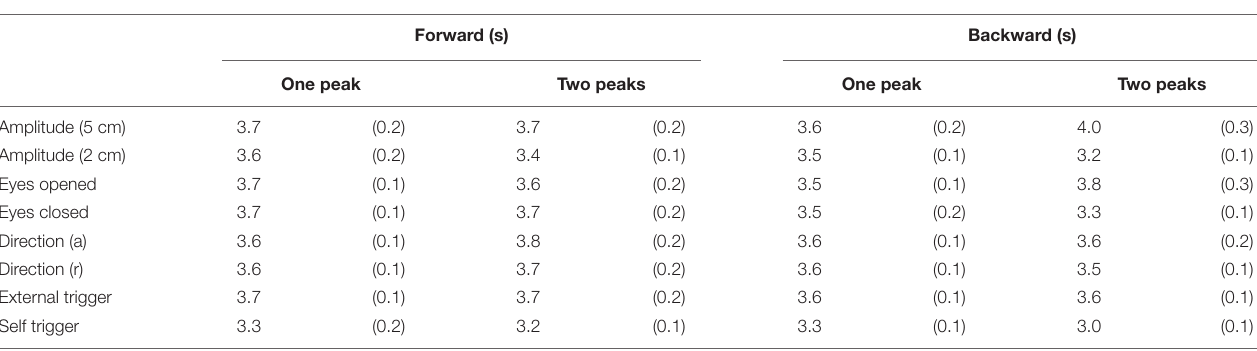
TABLE 9 | Peak latency of one-peak EDR and that of second peak in two-peak EDR.